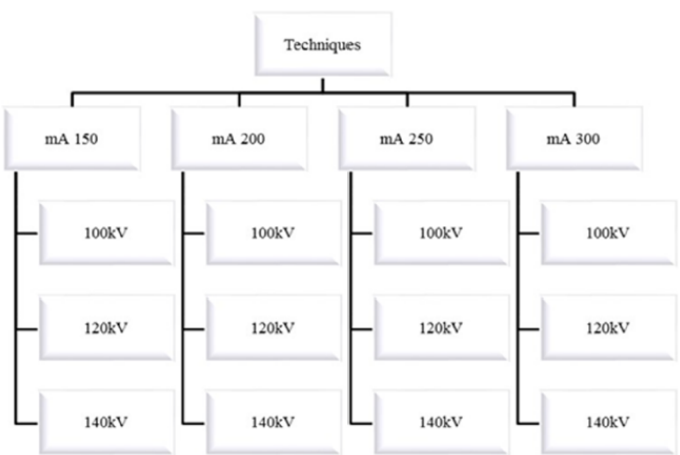
Figure 2. Schematic diagram demonstrating the 12 abdominal CT protocols used per each phan- tom setting.